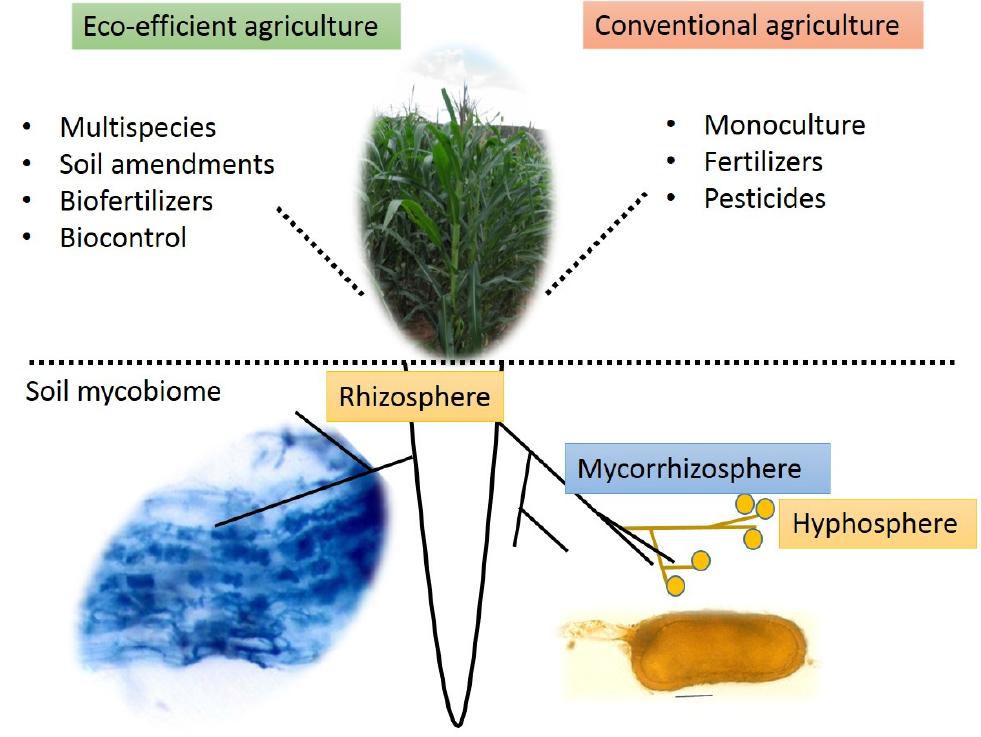
Figure 1. Schematic representation of the agriculture systems showing some characteristics and the different plant-soil compartments.